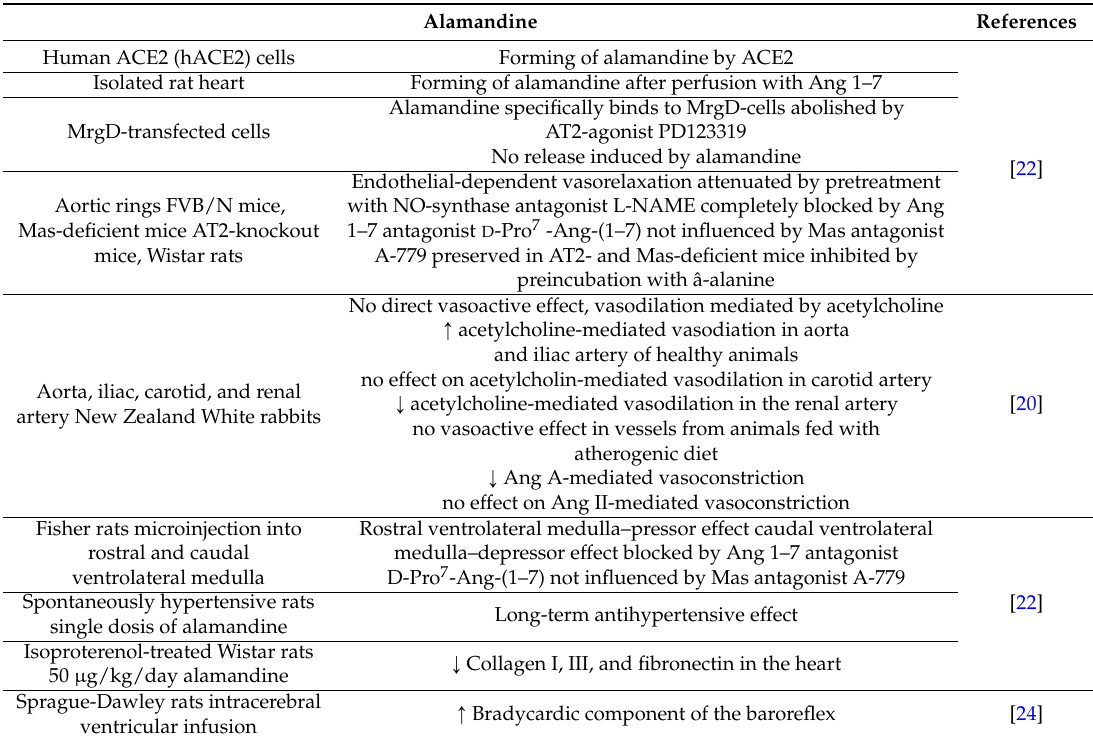
Table 2. Biological effects of